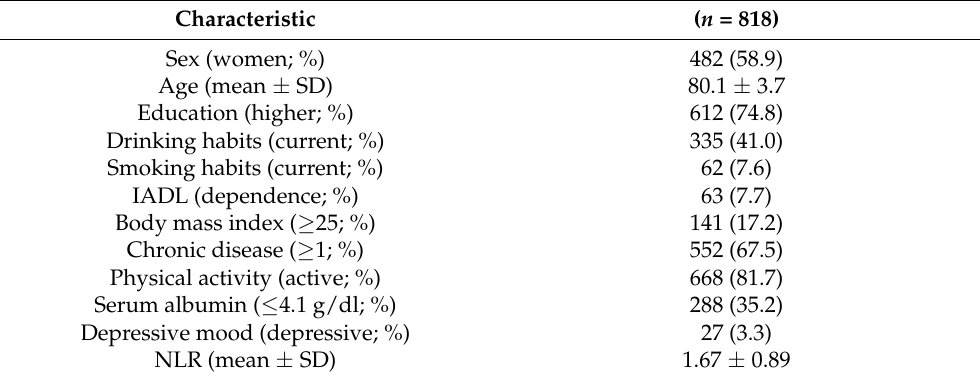
Table 1. Participant